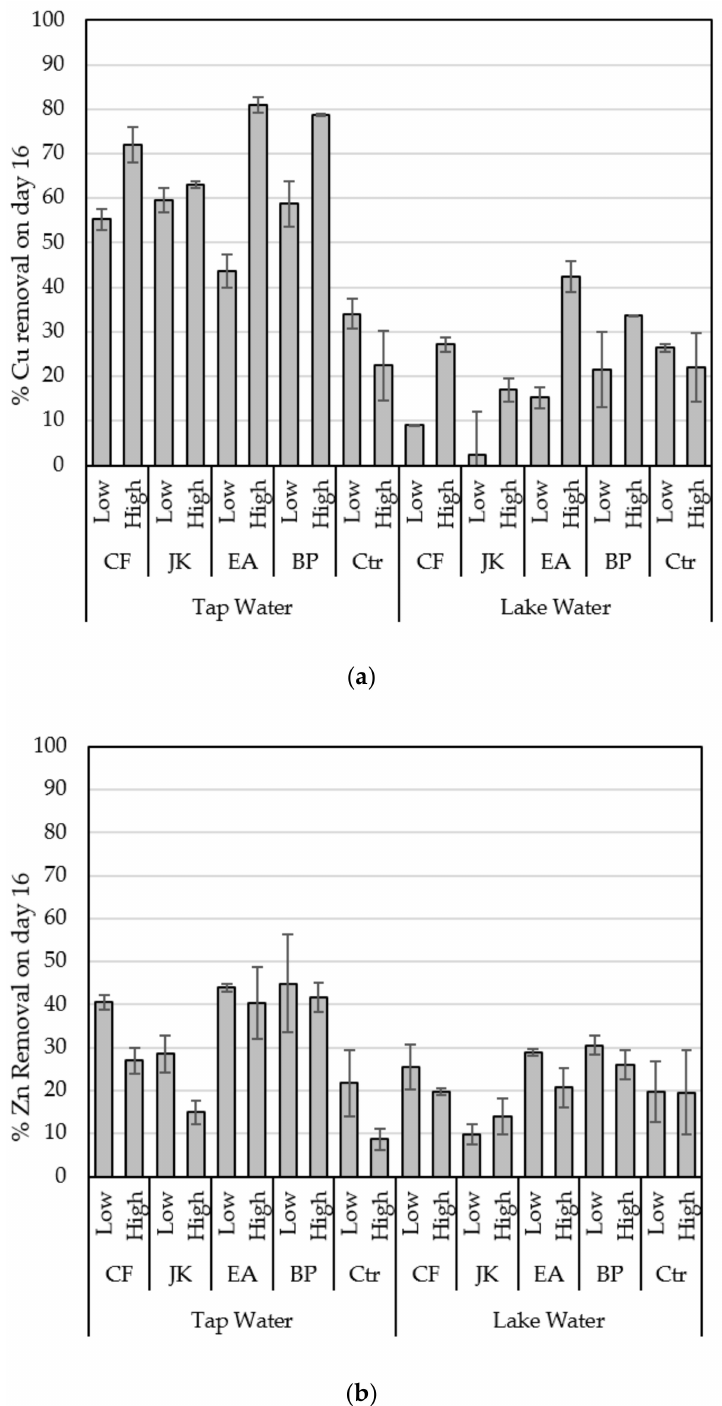
Figure 3. ( a ) Copper, ( b ) Zinc. Percentage removal of Cu and Zn after 16